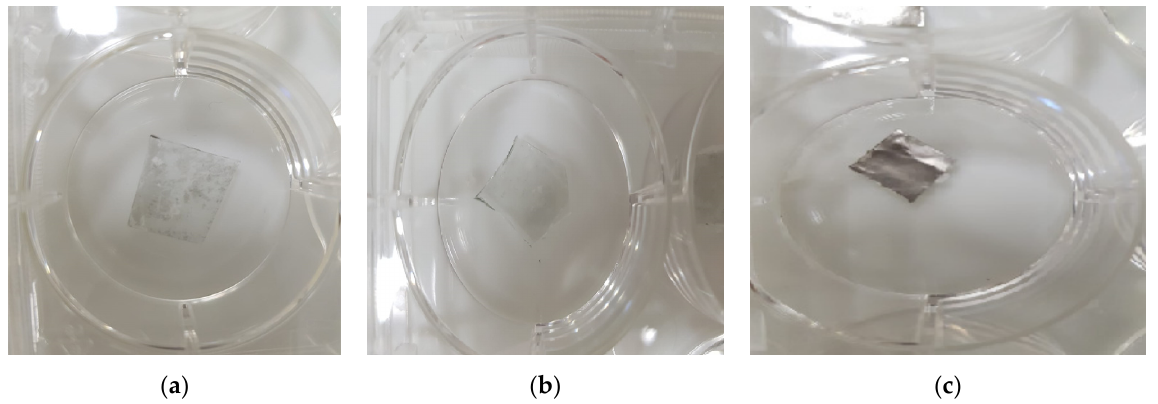
Figure 5. Digital photographs of ( a ) PECVD-grown Gr on glass substrate, ( b ) CVD-grown monolayer Gr on glass substrate, ( c ) CVD-grown monolayer Gr on Ni substrate .